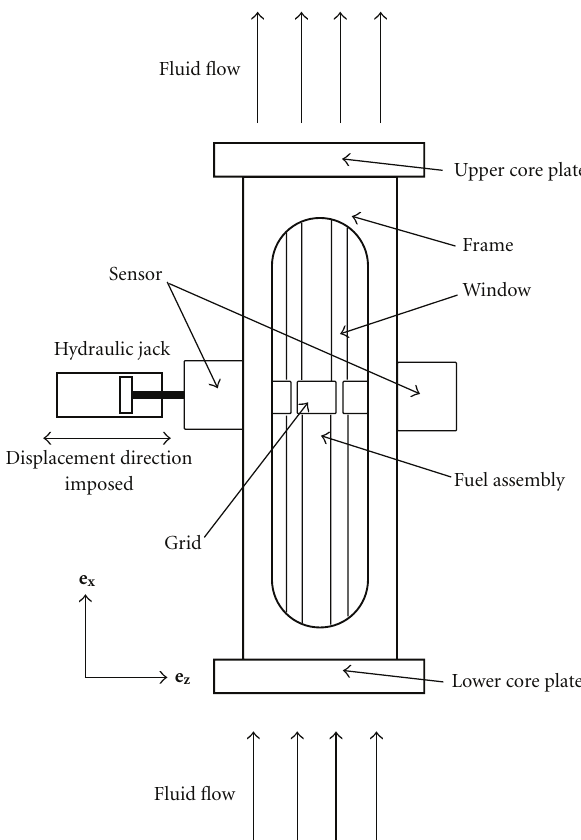
Figure 2: Experimental